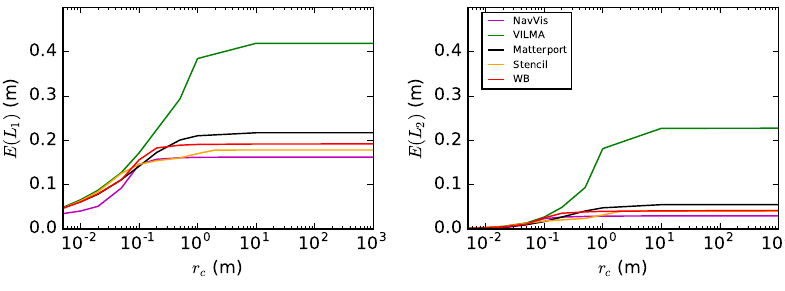
Figure 16. The error metric E , using L1 ( left ) and L2 ( right ) norms, as a function of the nearest point cut-off distance r c , car park test site. For VILMA (green line), E saturates a bit later than for Matterport (black line), the Wurzburg backpack (red line), Stencil (orange line) and NavVis (magenta line). No outliers are present, so the metrics describe the accuracy and precision of the point cloud.